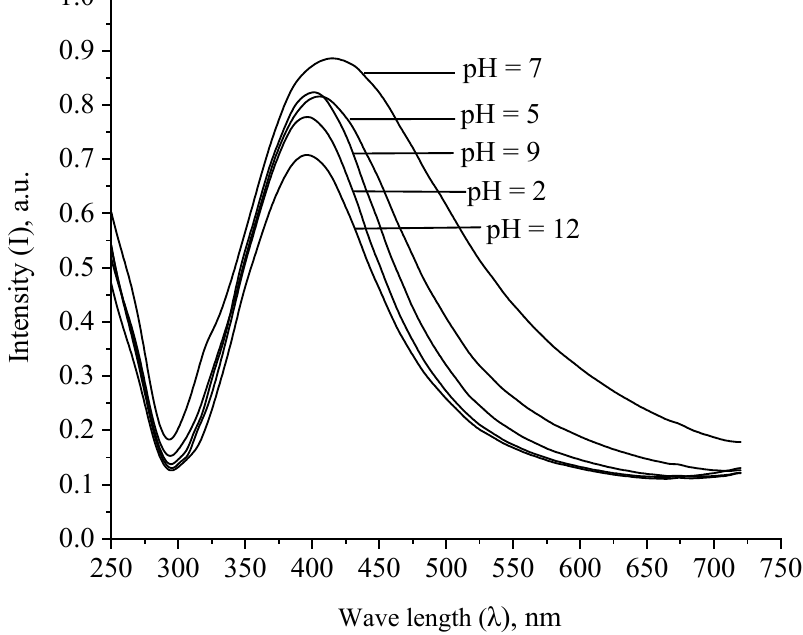
Figure 12. Absorption spectra of Ag NPs with different values of pH of the medium.